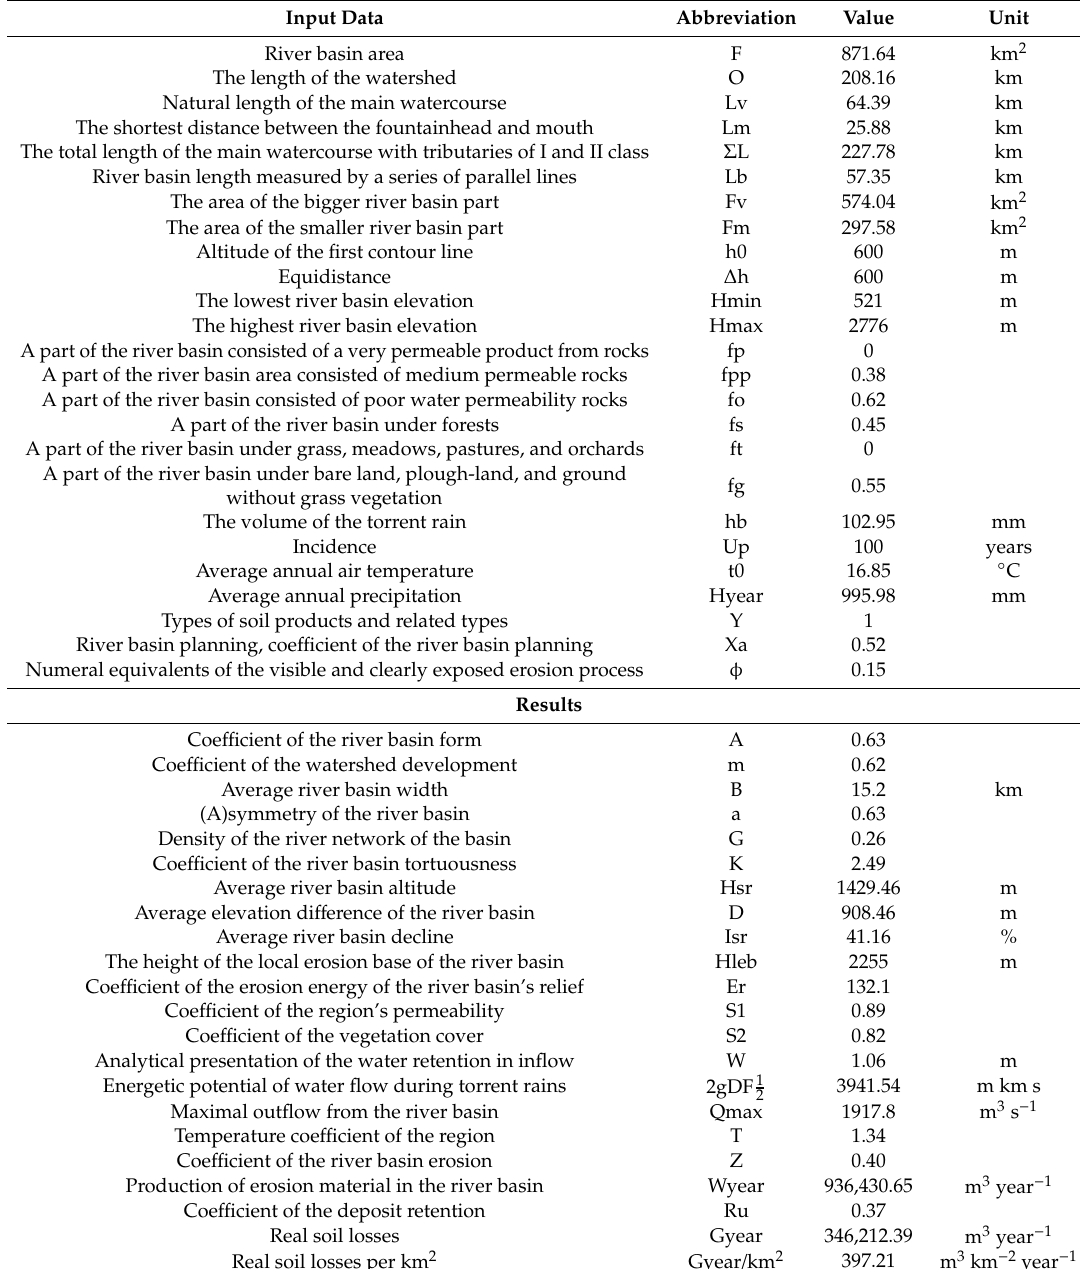
Table 5. IntErO report for the Sarada river